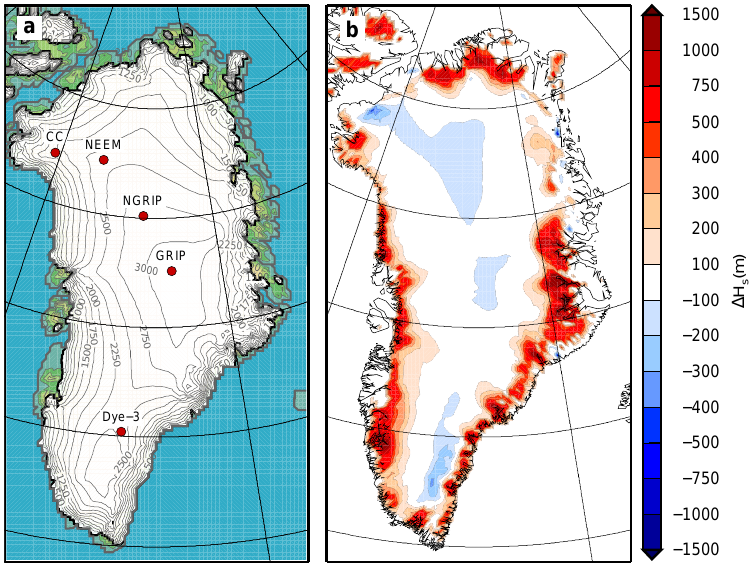
Fig. 9. (a) Steady-state ice sheet and (b) difference with present-day observed elevation after a 100kyr run using present-day climate forcing and the SMB gradient method.